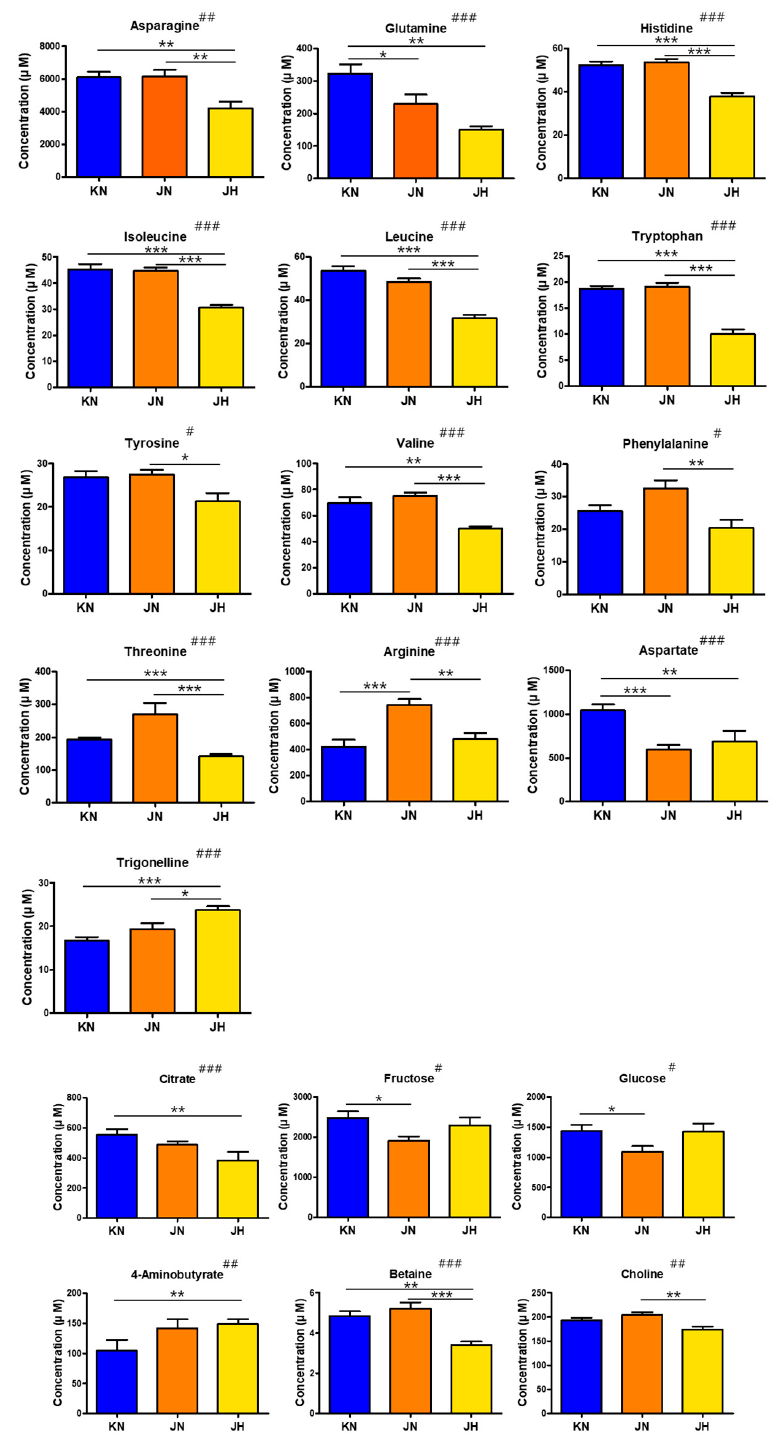
Figure 3. Quantification of metabolites in KN, JN, and JH of C. crenata chestnut. Kruskal–Wallis tests yielded significant differences determined by Dunn’s multiple comparison post hoc tests using GraphPad Prism 5.0. Significant differences in Kruskal–Wallis tests are represented as # p < 0.05, ## p < 0.01, and ### p < 0.001 and by Dunn’s multiple comparison post hoc tests are represented as * p < 0.05, ** p < 0.01, and *** p < 0.001. Error bars indicate means ± standard deviation. Letters on the horizontal axis represent: KN, Korean native or crossbred between Korean native; KH, Korean hybrid which crossbreeds with other origins; JN, Japanese native or crossbred between Japanese native; JH, Japanese hybrid which crossbreeds with other origins.